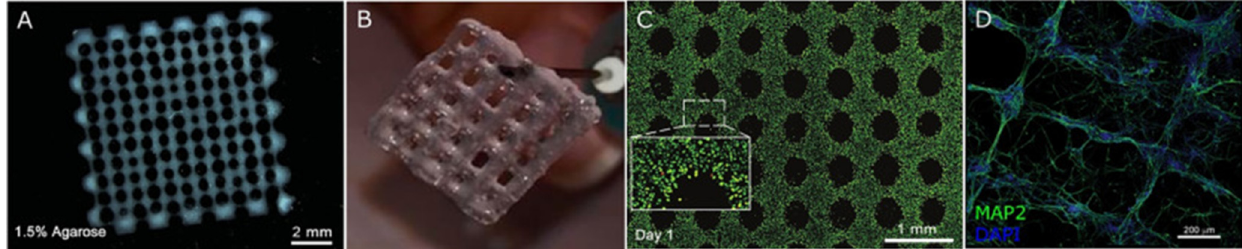
Figure 6. Images of various 3D bio-printed scaffolds. ( A ) Human neural stem cells (hNSCs) embedded in an alginate (Al)/agarose (Ag)/carboxymethyl-chitosan (CMC)-based hydrogel. Reprinted with permission from Gu, Q.; Tomaskovic- Crook, E.; Lozano, R.; Chen, Y.; Kapsa, R.M.; Zhou, Q.; Wallace, G.G.; Crook, J.M. (2016). Copyright 2016 Advanced Healthcare Materials, John Wiley and Sons [122]. ( B ) Neuroblastoma cells embedded in Al/gelatin hydrogel. Reprinted with permission from Fantini, V.; Bordoni, M.; Scocozza, F.; Conti, M.; Scarian, E.; Carelli, S.; Di Giulio, A.M.; Marconi, S.;